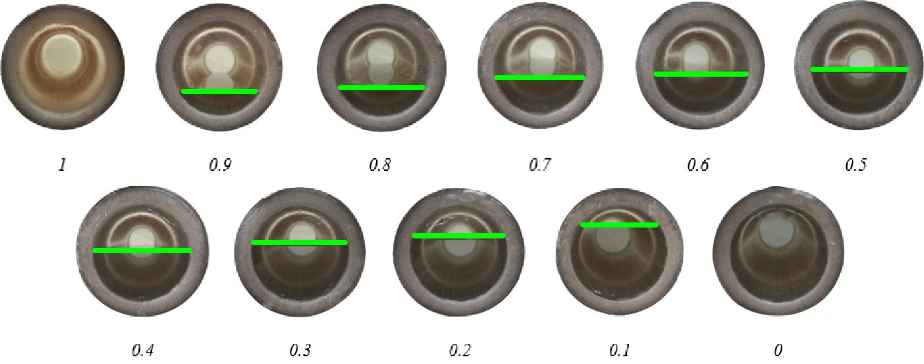
Figure 1. Different water levels in the cross-section of the pipe to create different void fractions in the experimental experiment where the water level is highlighted with a green line on each image of different void fractions.